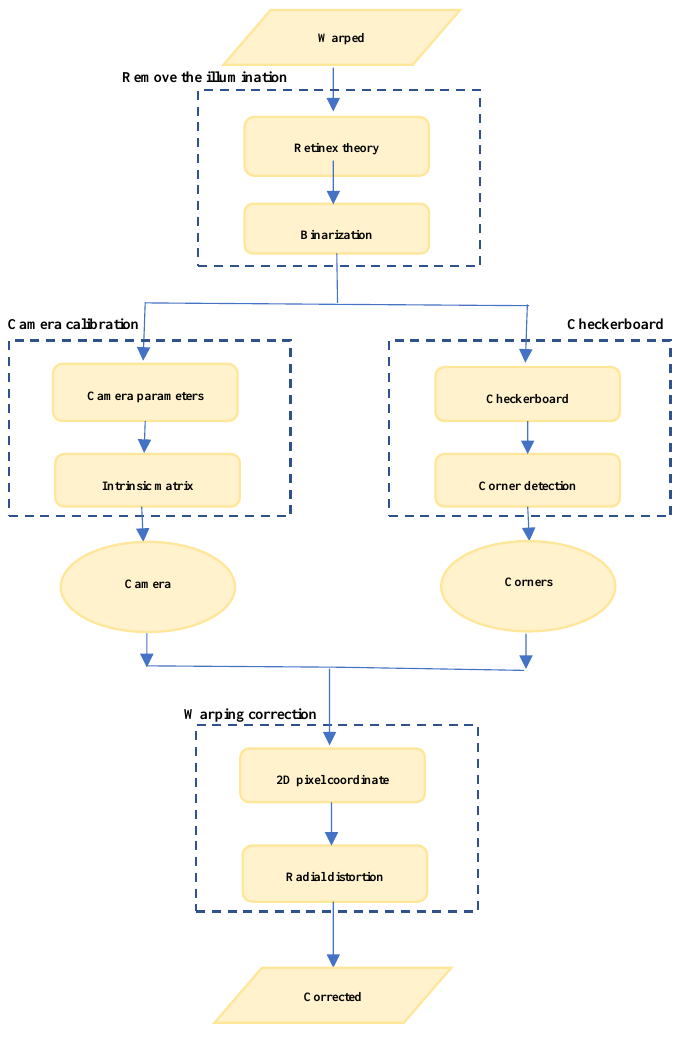
Figure 2. General block diagram of our method.